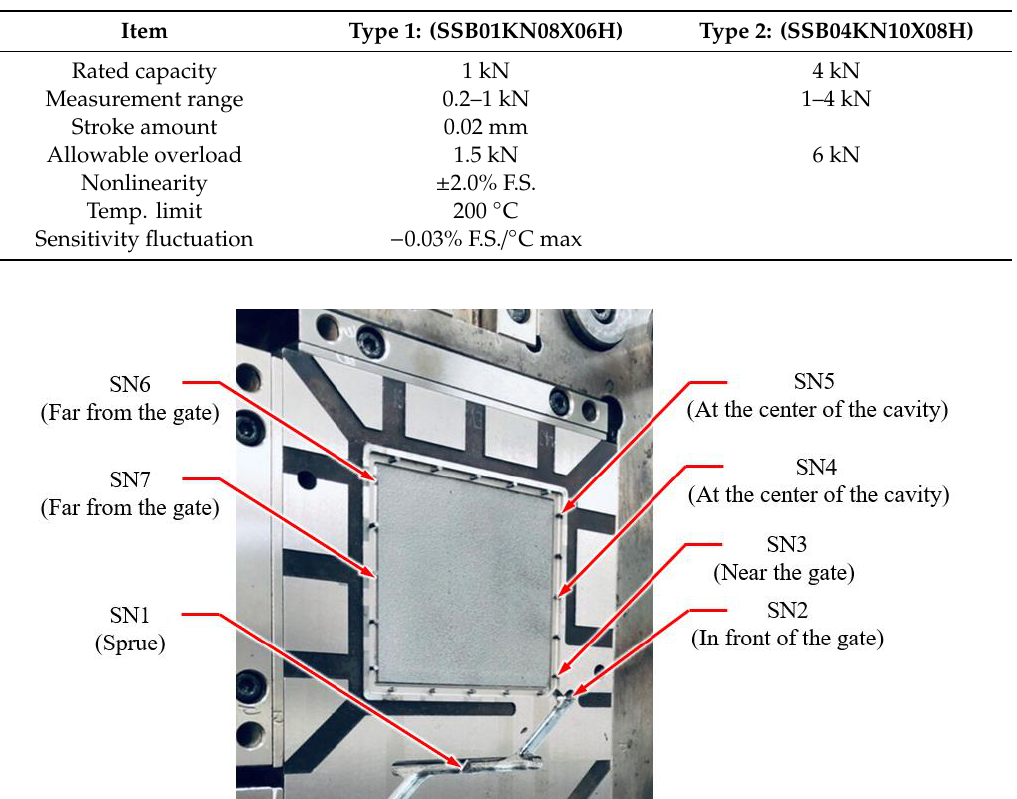
Figure 9. Positions of the pressure sensors installed in the cavity.